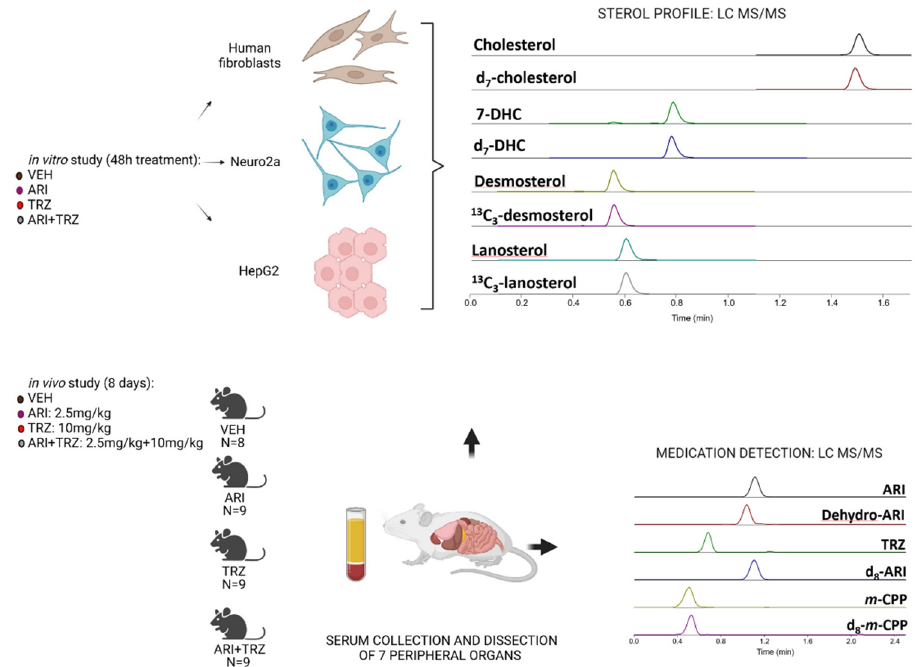
Figure 1. Experimental design of the study. In vitro experiments: HepG2, Neuro2a and human dermal fibroblasts were treated with ARI, TRZ or ARI+TRZ. CHOL, DES, 7-DHC, and LAN were analyzed with PTAD derivatization assay by LC-MS/MS. In vivo experiments: mice were treated with ARI (2.5 mg/kg), TRZ (10 mg/kg), ARI+TRZ (2.5 mg/kg + 10 mg/kg), or vehicle (VEH) for 8 days. Sera were collected and peripheral tissues were dissected (heart, lungs, pancreas, spleen, liver, kidneys, adrenal glands) for measurements of sterols, ARI, TRZ and their main metabolites by